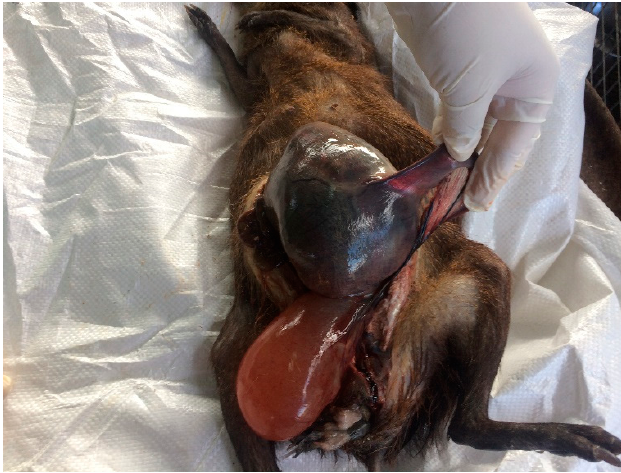
Figure 1. Necropsy of Adult Agouti with oversized foetus in the right uterine horn which resulted in the death of the animal.